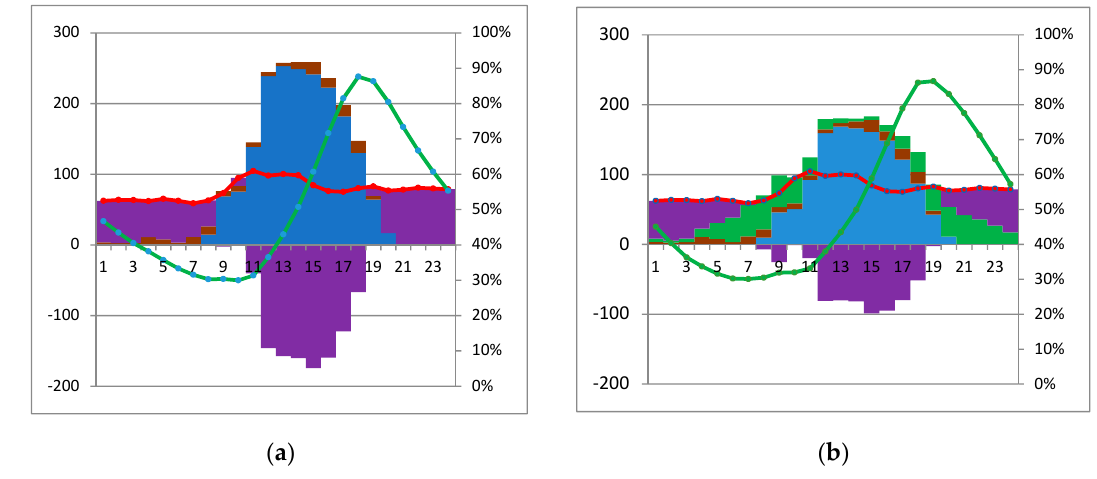
Figure 10. Day 6, 10/08/2009: Energy balance ( a ) without and ( b ) with tidal energy.